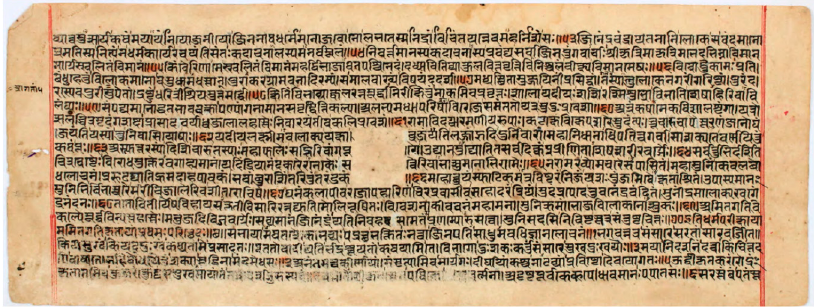
Figure 4. Dharmapar ī k ṣ ā by Amitagati, Kob ā T ī rth n. 12092 40 . Figure 4. Dharmapar¯ıks. ¯a by Amitagati, Kob¯a T¯ırth n. 12092 40 .